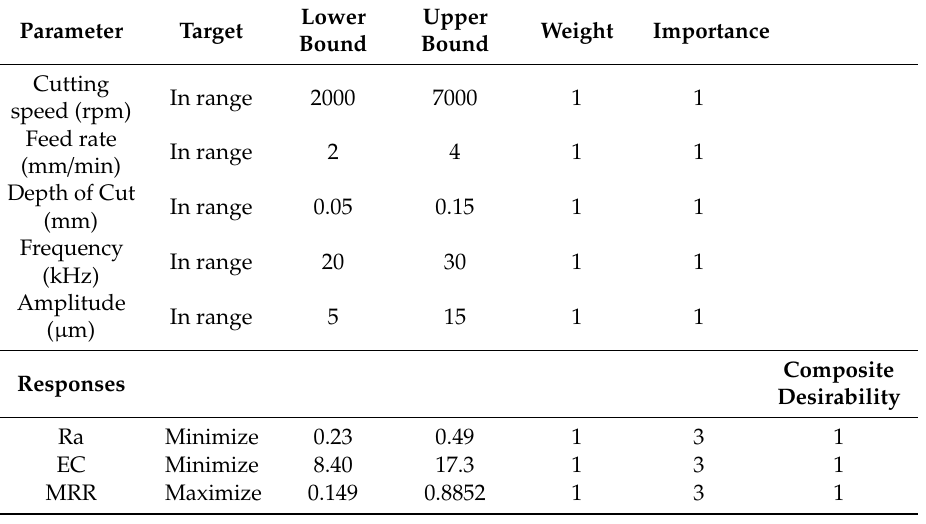
Table 8. Boundaries of RUM parameters for Ra, EC, and